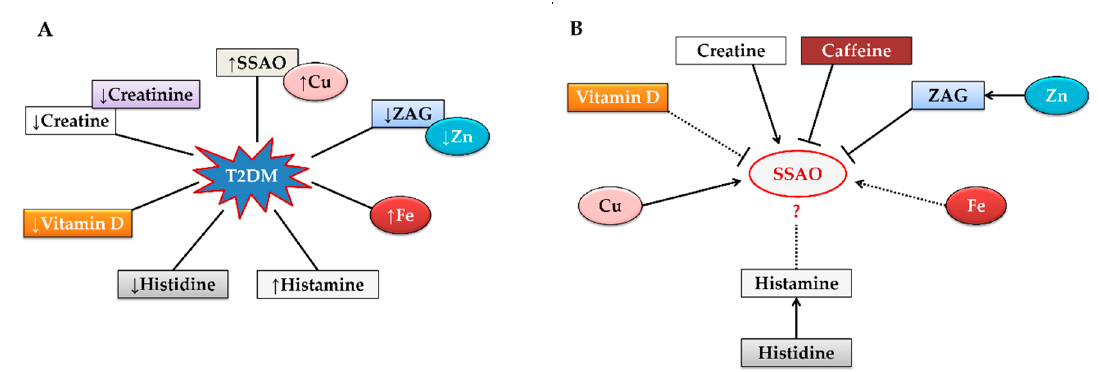
Figure 2. ( A ) The concurrence of certain natural agents in plasma of T2DM patients. ( B ) The impact of certain natural agents on SSAO